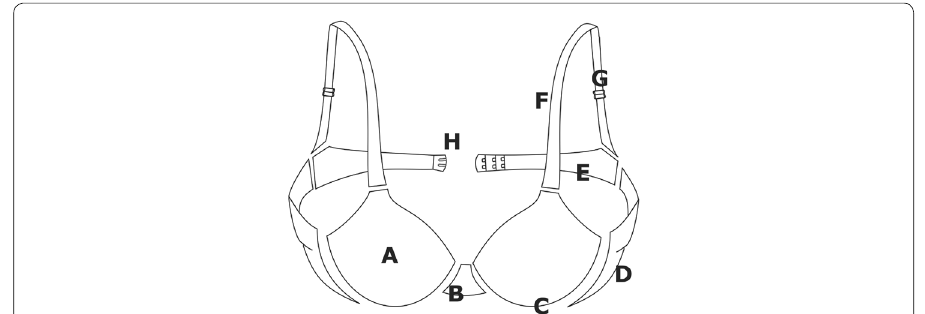
Fig. 1 Structure of a bra: A cup, B band, C underwire, D wings reinforcement, E underband, F straps, G strap adjustment rings and sliders and H